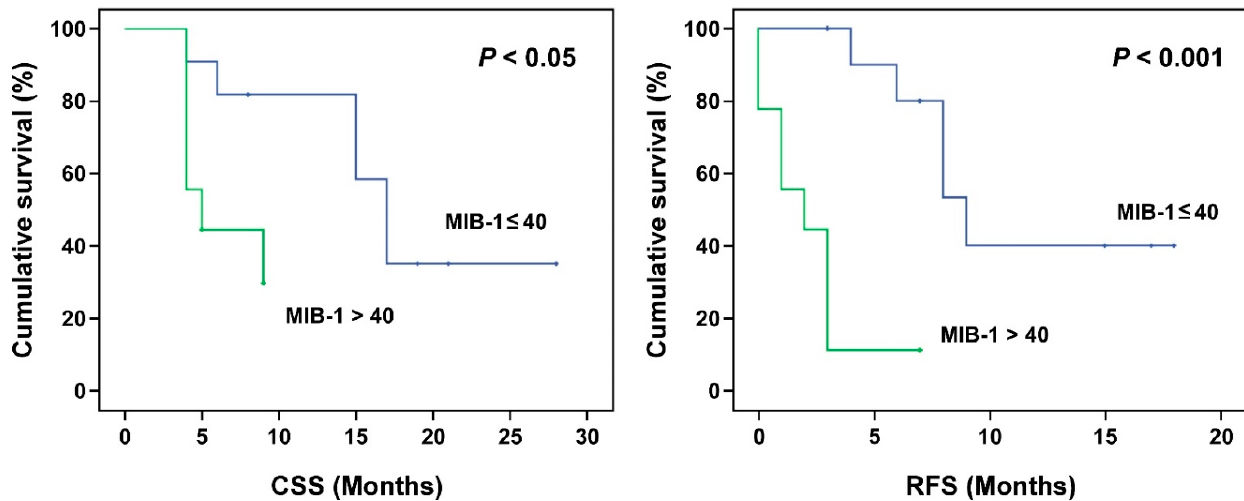
Figure 2. Kaplan–Meier survival curve of tumors with MIB-1 ≤ 40 and MIB-1 > 40. A MIB-1 labelling index higher than 40% predicted poor cancer-specific survival (CSS) and poor relapse-free survival